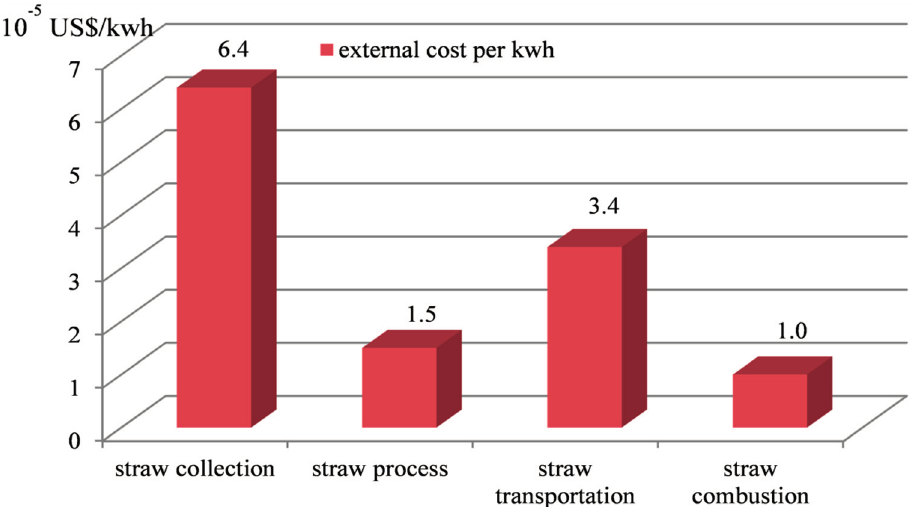
Figure 6. External costs of a 30 MW biomass power plant per